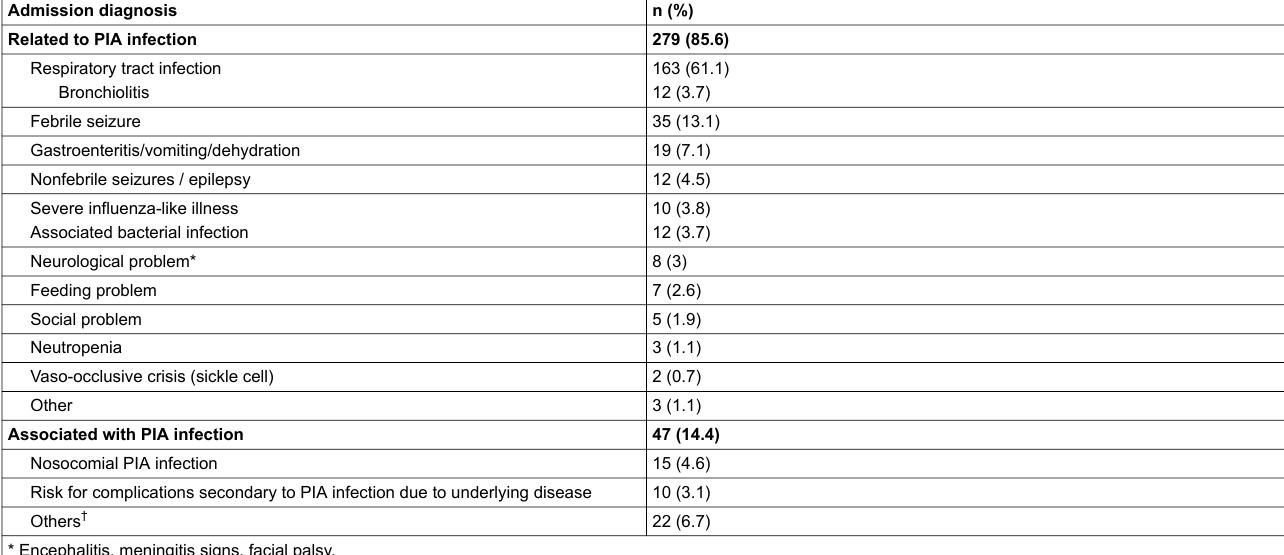
Table 2: Reasons for hospitalisation of 326 children with laboratory-proven pandemic influenza A/H1N1/09 virus (PIA) infection. Admission